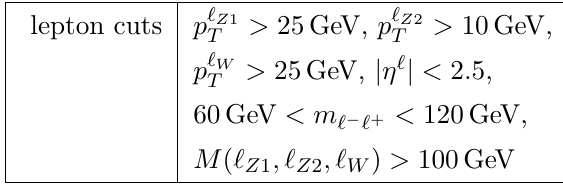
√ s = 13 TeV presented in ref.